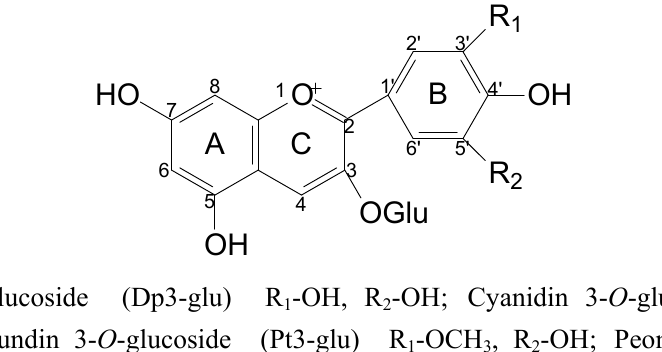
Figure 1. Structures of the five common anthocyanin